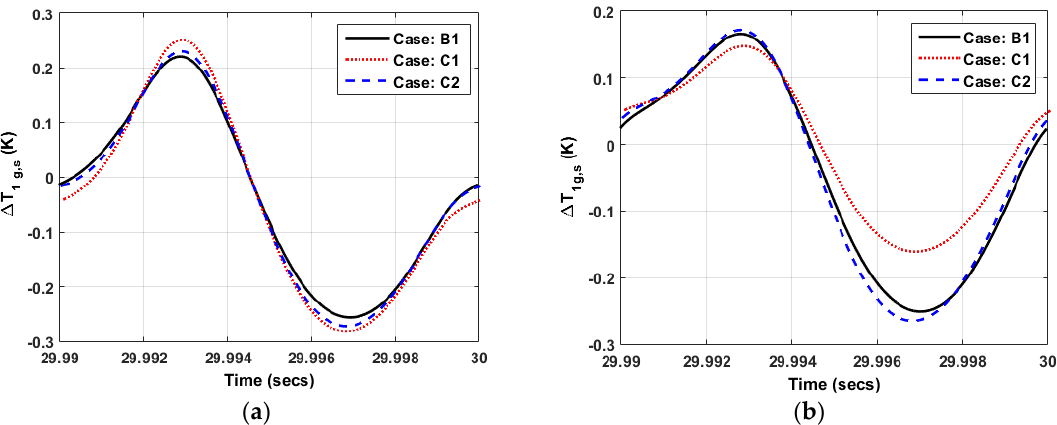
Figure 8. Comparison of ∆ T 1 | stack cold end.